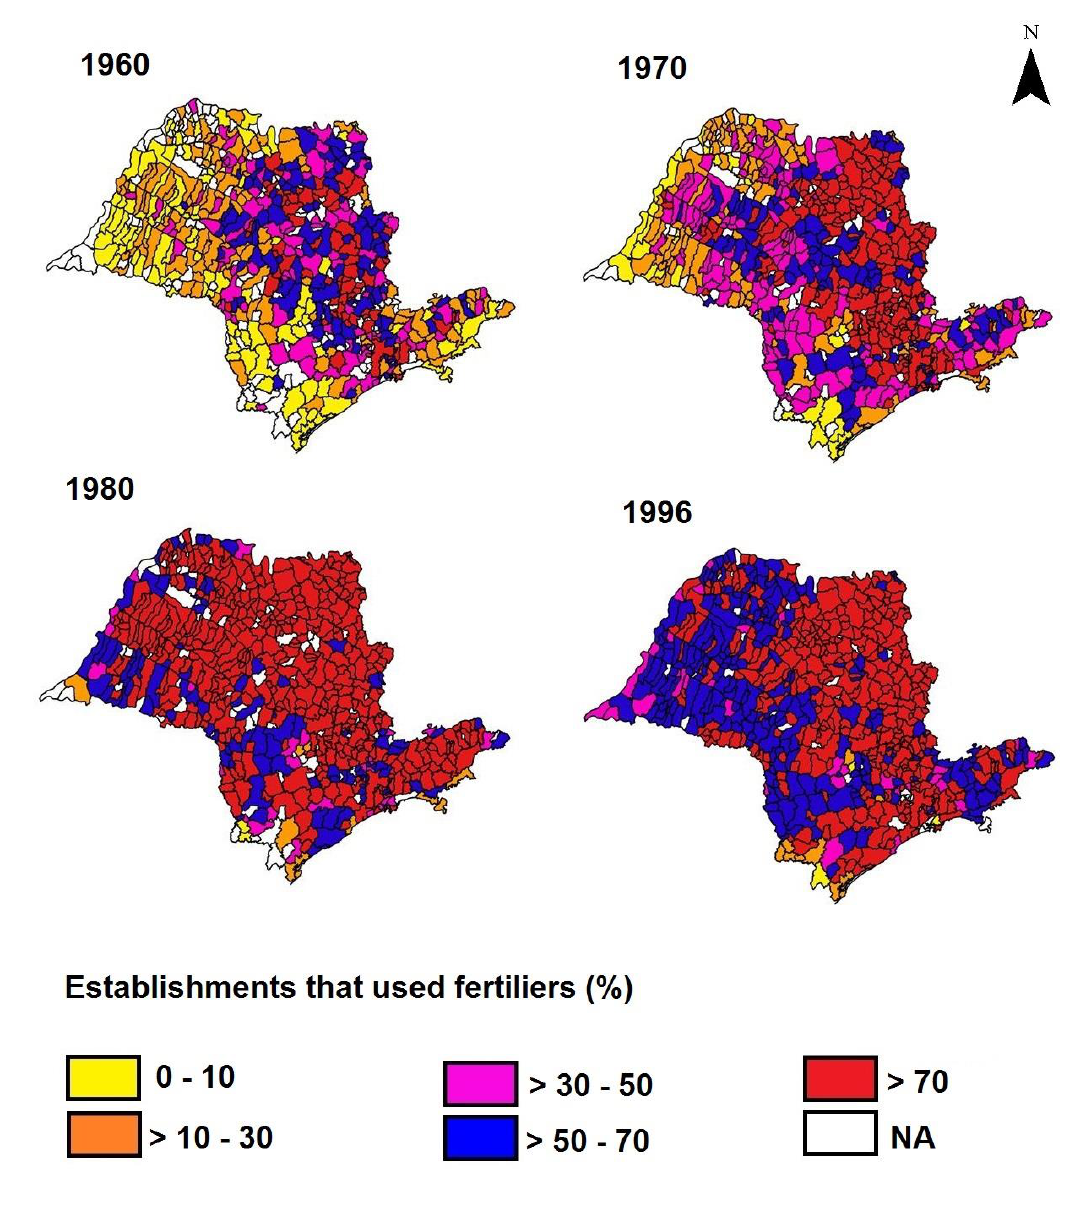
FIGURE A1.3 Percentage of establishments that used fertilizer at the municipality-scale for São Paulo state calculated for the years 1960, 1970, 1980 and 1996. Municipality boundaries are shown in black. (NA) Missing